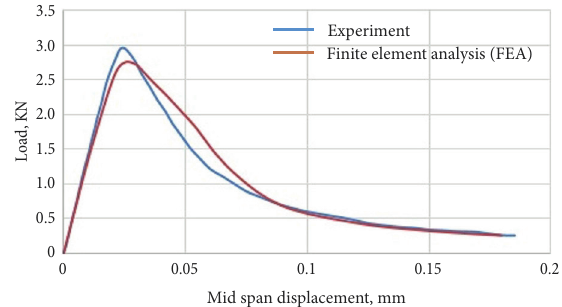
Fig. 22. Comparison of load-displacement responses obtained Fig. 20. The value of objective function versus dilation angle from FEA and experiment (Le Bellego et al. 2003) in three-point notch beam in three-point bending notched beam with small size